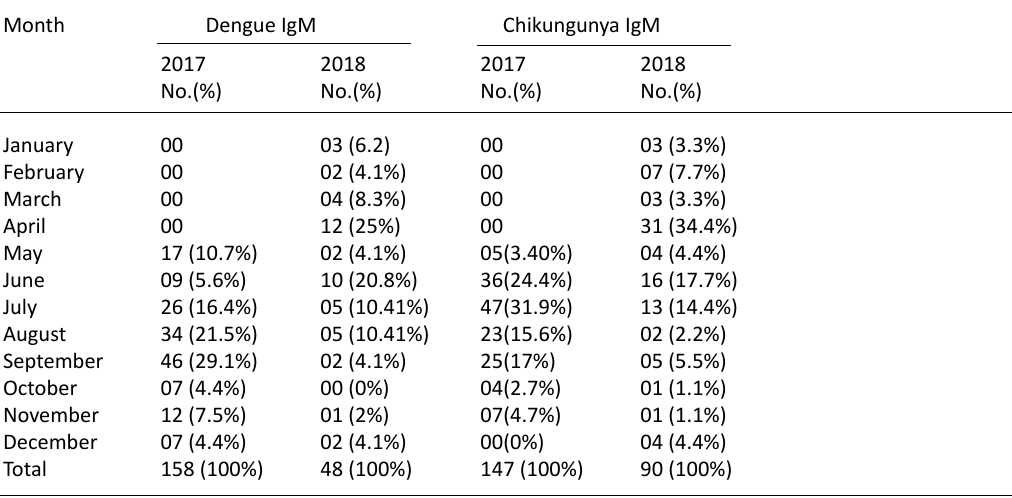
Table 5. Month wise distribution of Dengue and Chikungunya infection in 2017 and 2018